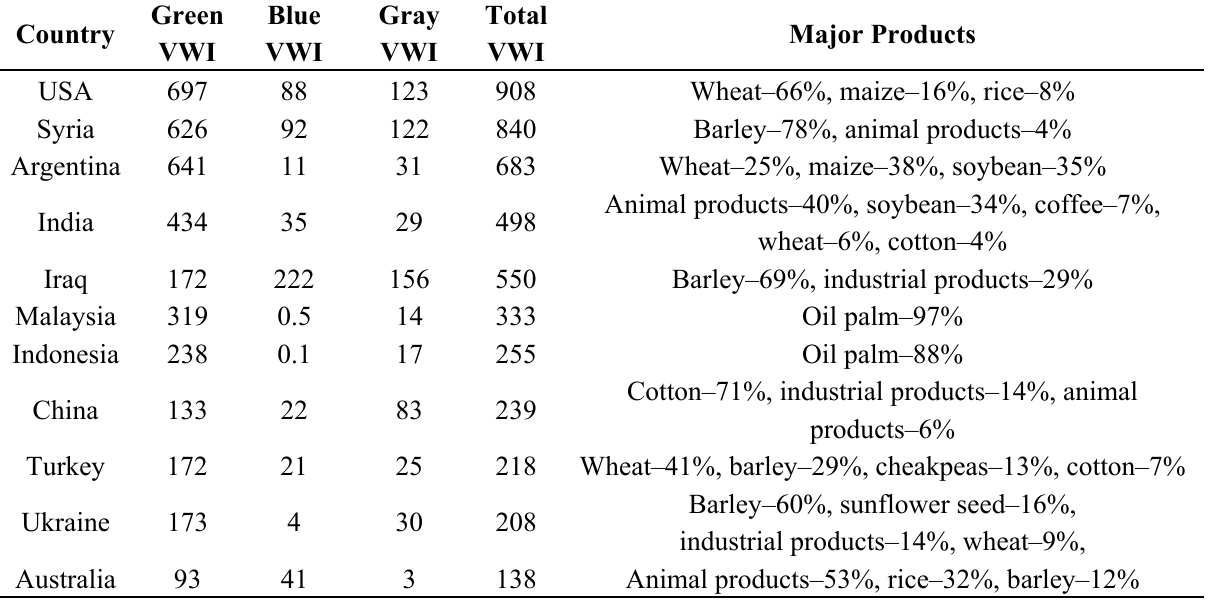
Table 6. Jordan’s virtual water import (VWI) per major trade partner (10 6 m³/year). Period: 1996–2005. Data based on